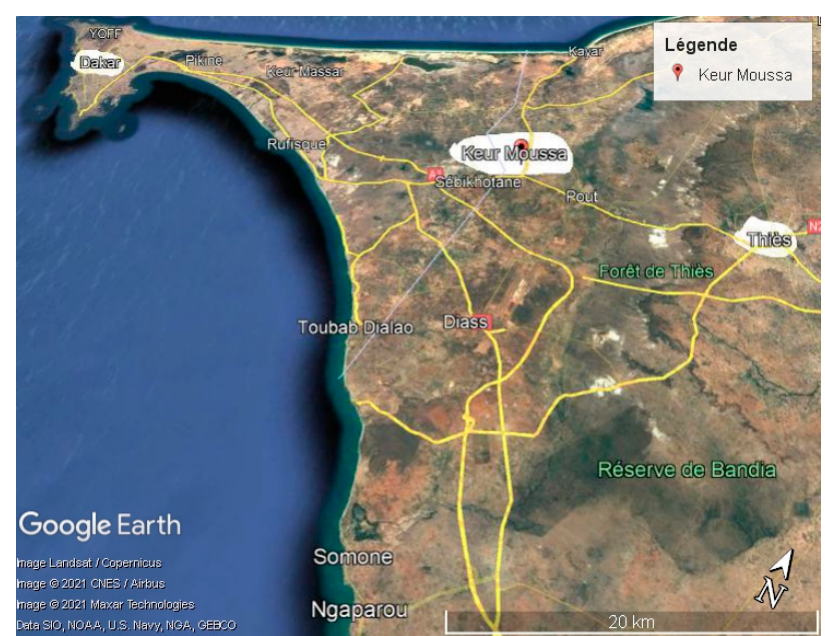
Figure A1. Google Map indicating the location of the rural community of Keur Moussa (studied site) in Senegal.